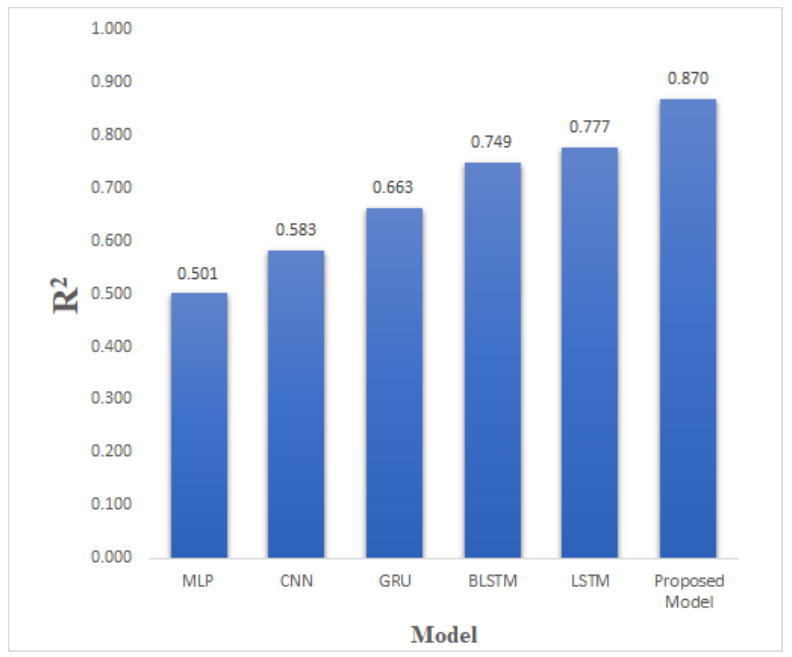
Figure 8. R 2 values of 5 deep learning models and the proposed model.